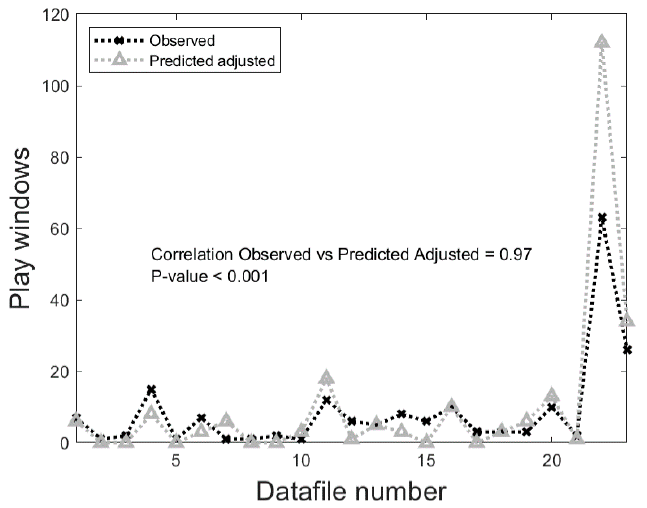
Figure 5. Comparison of the number of window samples predicted and the number of window samples observed for each individual dataset. Table 3. Percentage decrease in algorithm performance by behaviour when down-sampling from 100 Hz to 50 Hz, from 100 Hz to 20 Hz, from 100 Hz to 10 Hz and from 100 Hz to 4 Hz.